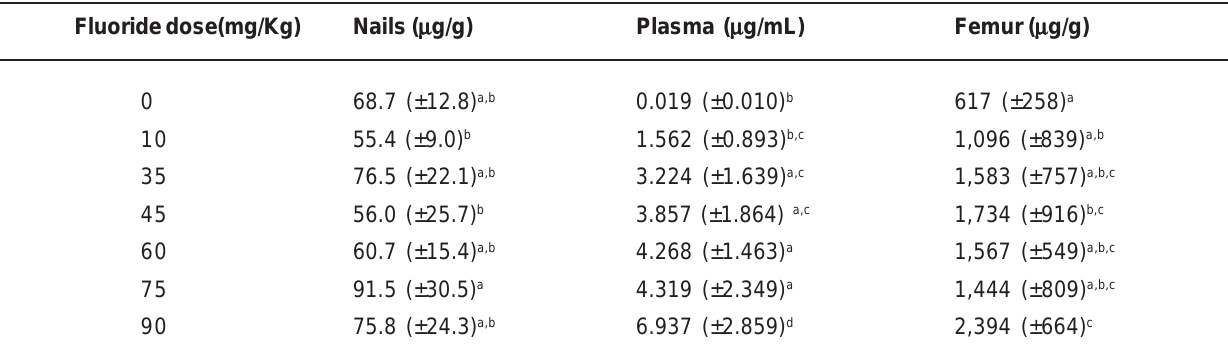
TABLE 1- Mean (±SD; n=10) fluoride concentration in rat nails, plasma and femur surface after single-dose fluoride administration (mg/kg body weight)